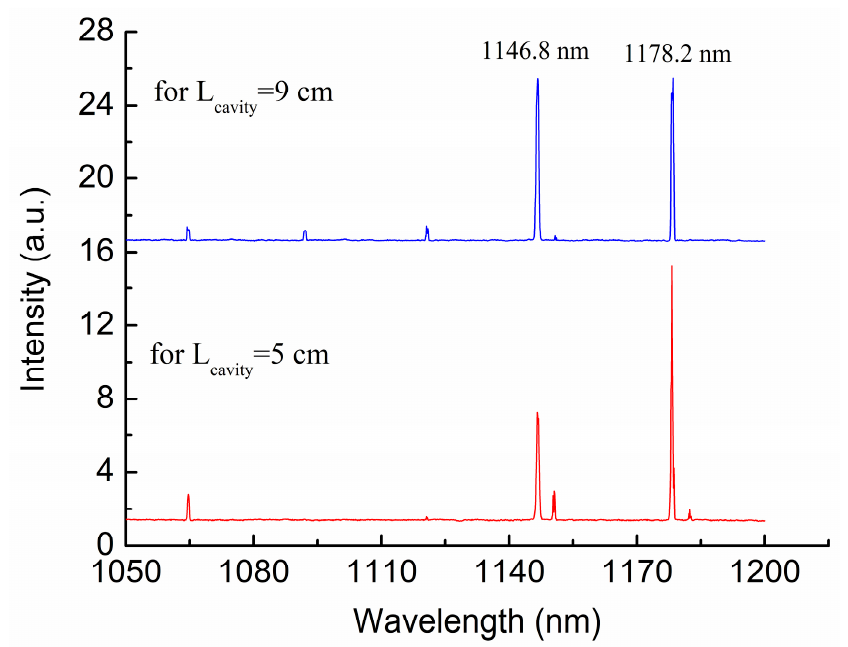
Figure 4. Raman laser spectra measured under the incident pump power of 10.5 W with the cavity lengths of 5 cm and 9 cm.